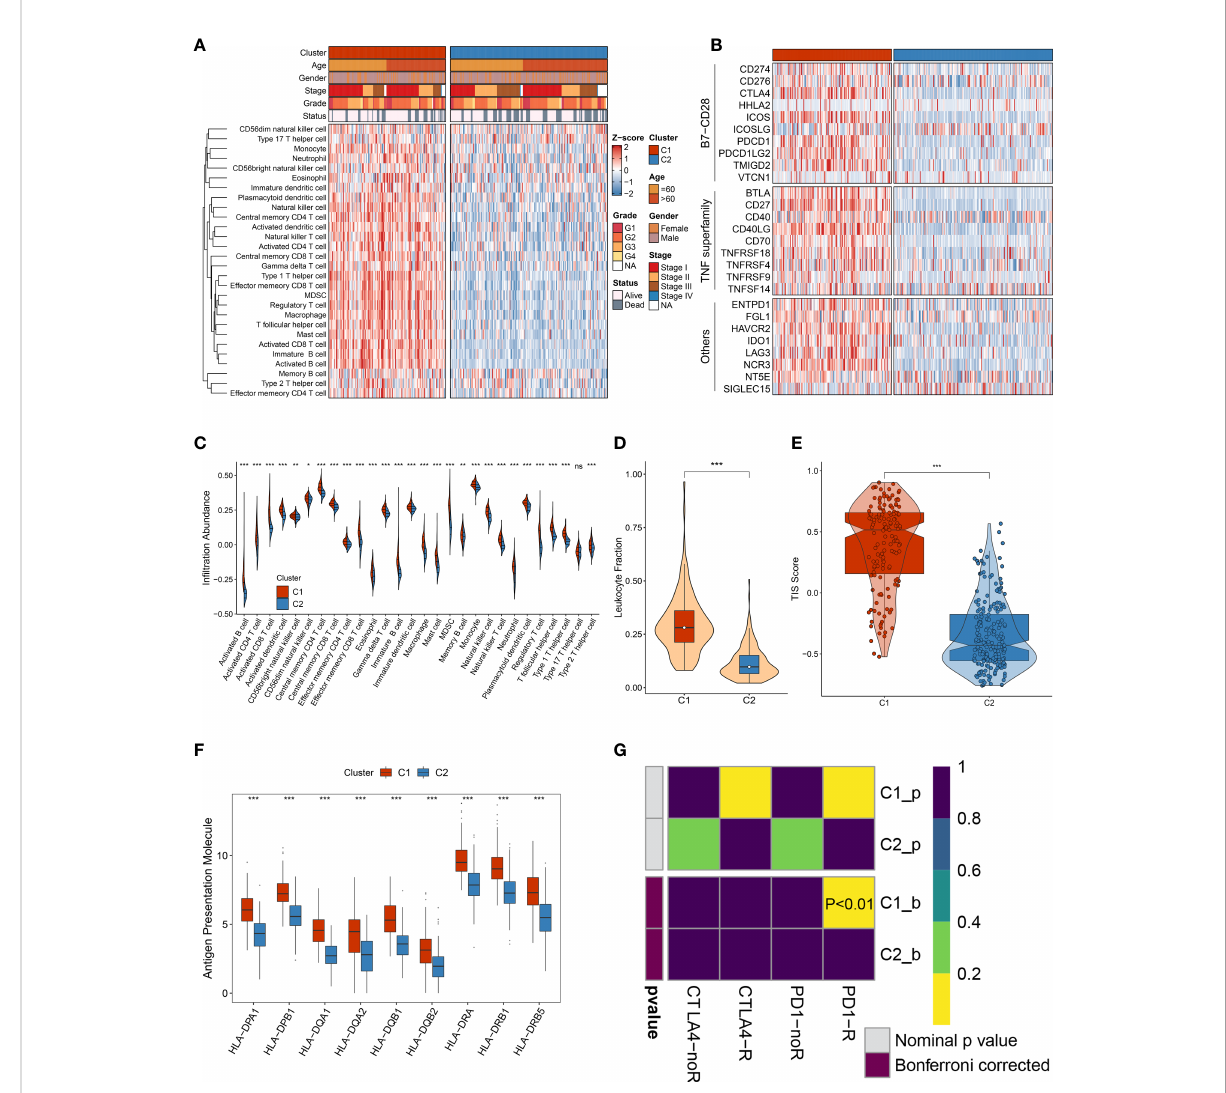
FIGURE 9 The immune landscape of heterogeneous necroptosis subtypes. (A) The in fi ltration abundance of 28 immune cell subsets was evaluated by single-sample gene set enrichment analysis (ssGSEA) algorithm. (B) The immune checkpoint pro fi les of necroptosis subtypes, including B7- CD28 superfamily, TNF superfamily, and other molecules. (C) Distribution of 28 immune cell in fi ltration between necroptosis subtypes in TCGA- LIHC dataset. (D) The comparison of leukocyte fraction between necroptosis subtypes. (E) Distribution difference of T-cell in fl ammatory signature (TIS) prediction scores between necroptosis subtypes. (F) Distribution of nine HLA molecular expressions between necroptosis subtypes. (G) Submap analysis exhibited that C1 could be more sensitive to the anti-PD-1 therapy (p < 0.01 ) ns, p >0.05, *p < 0.05, **p < 0.01, ***p <